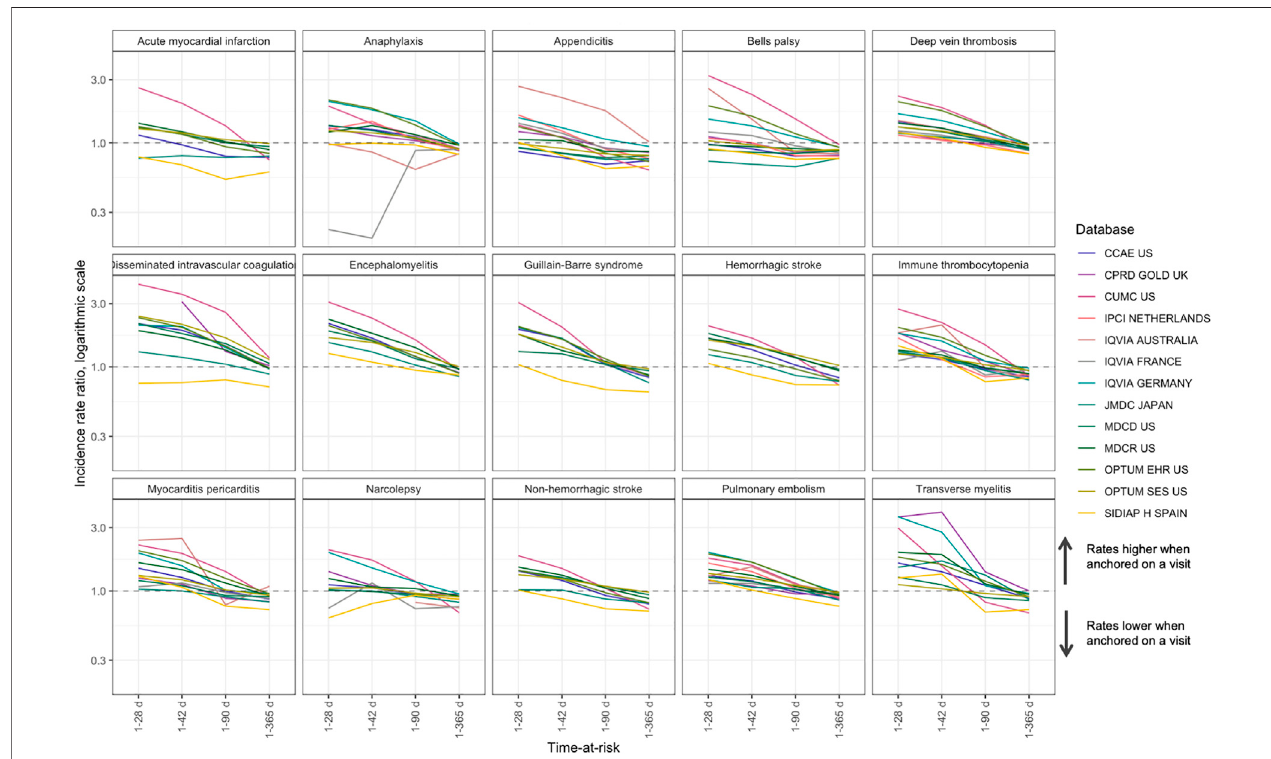
FIGURE4| ComparisonofanchoringonarandomvisitversusanchoringonJanuary1stinpatientswithavisitinthenextyearfortime-at-risk1 – 28,1 – 42,1 – 90and 1 – 365 days, incidence rate